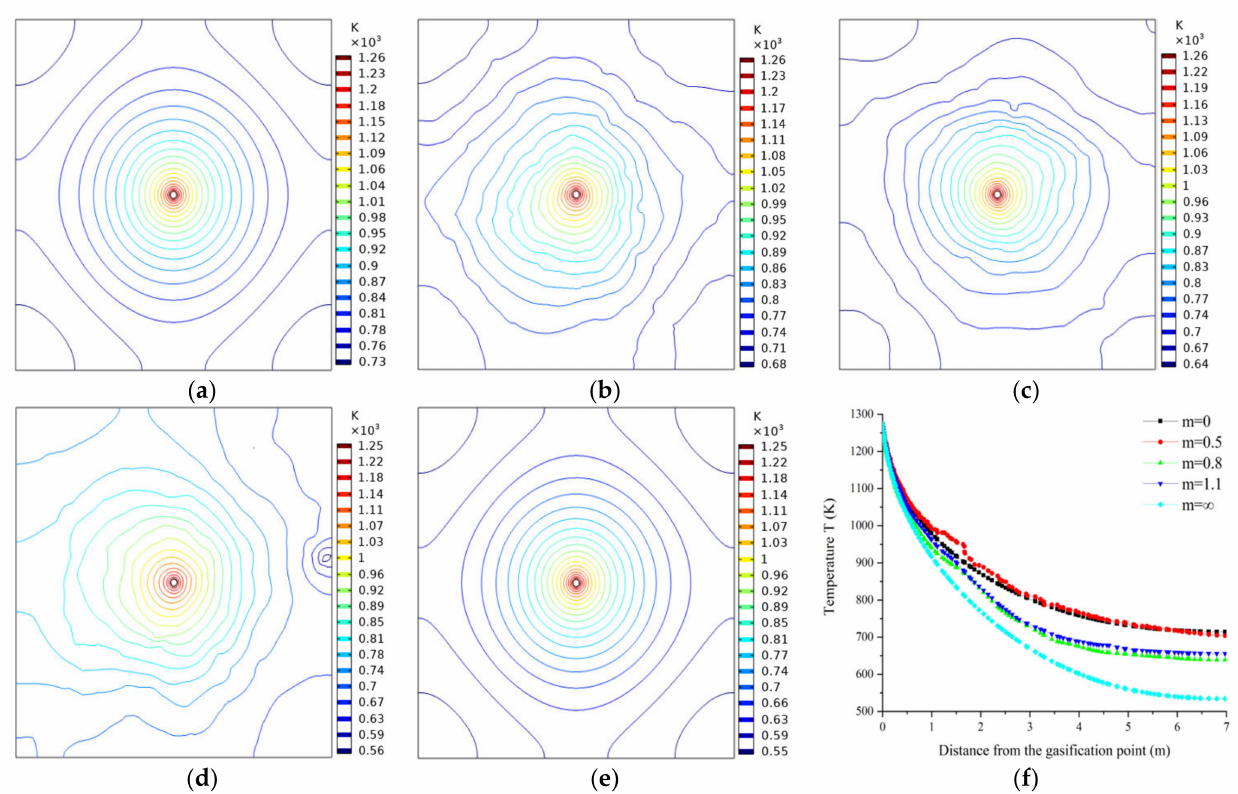
Figure 6. Temperature distribution cloud diagram of different fracture densities. ( a ) m = 0; ( b ) m = 0.5; ( c ) m = 0.8; ( d ) m = 1.1; ( e ) m = ∞ ; ( f ) the relationship between temperature and distance from the gasification